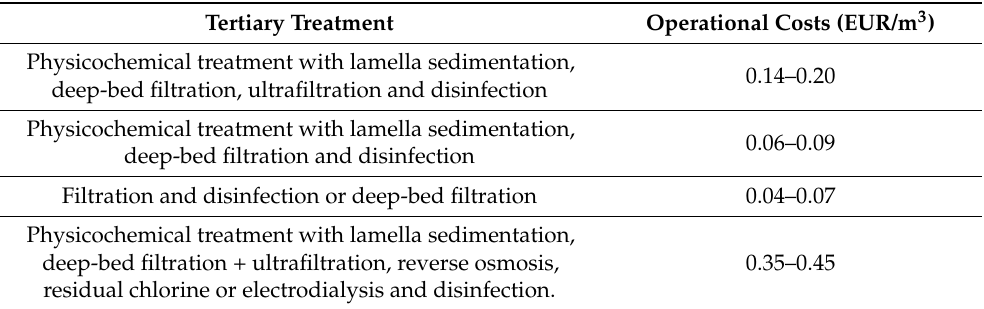
deep-bed filtration + ultrafiltration, reverse osmosis, residual chlorine or electrodialysis and